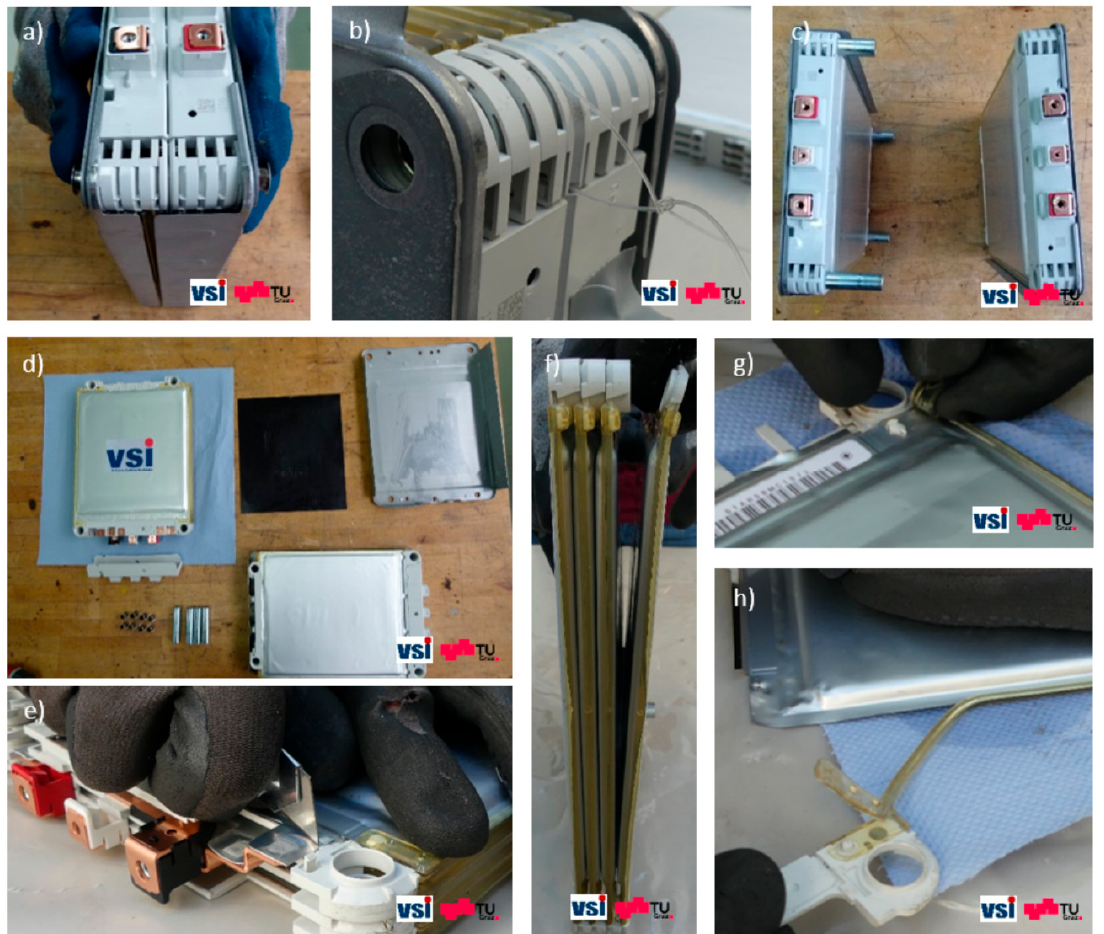
Figure 2. Battery module disassembly method. ( a ) Removal of the caps and bolts that hold the module together; ( b ) separation of the two four-cell stack with a 0.7 mm nylon rope; ( c ) module separated into two parts; ( d ) module disassembled into parts (two four-cell stacks, module housing, compression pad, and connection bolts); ( e ) cutting the tab connection; ( f ) separation of the cells from each other using a nylon rope; ( g ) location of the connection points between the plastic frame and the pouch; and ( h ) removal of the plastic frame.